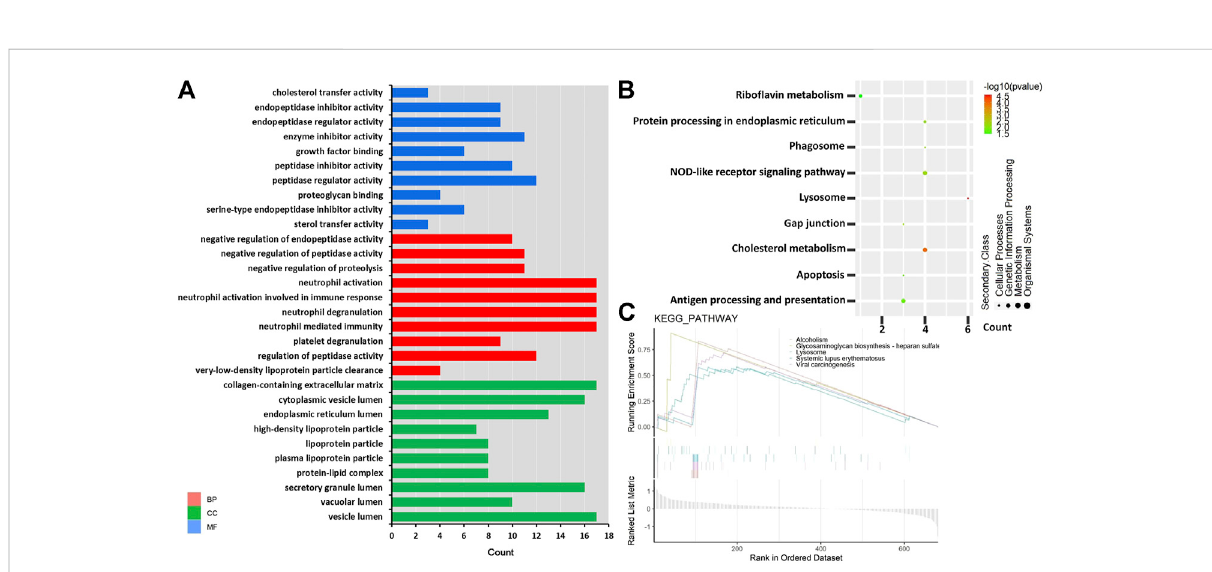
FIGURE 3 GO and KEGG pathway enrichment based on DEPs. (A) Top 30 GO terms in three domains. Red shows DEPs enriched in the biological process (BP); blueshows DEPs enriched in themolecularfunction (MF); and green shows DEPsenrichedin thecellular component(CC). The left isthe name of the GO term, while the right column represents the counts of DEPs. (B) KEGG enrichment items. The left is the name of the KEGG pathway, the rightrepresentsenrichment,andthesizeofthesolidcircleindicatesthenumberofgenes. (C) GSEAofidenti fi edDEPs. Theabscissaisthelistof whole genes sorted by logFC; the upper half of the ordinate is dividedinto enrichment scores, the lower half is divided into log2FC, and the pathway type is represented by the color